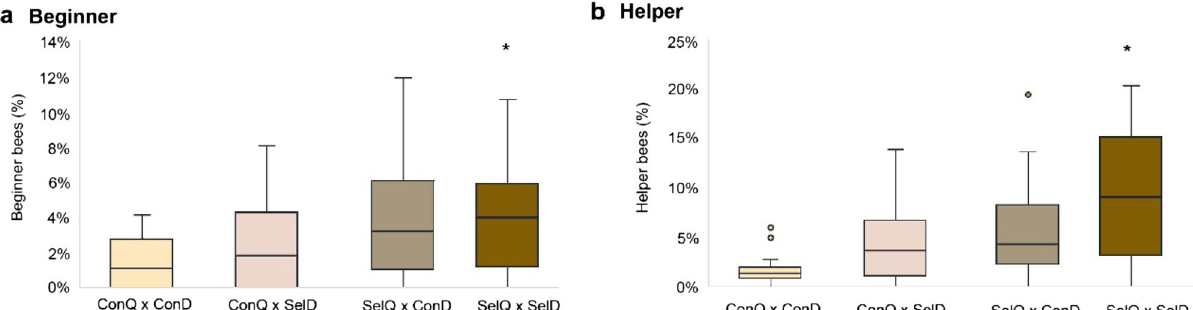
Figure 4. Boxplot of beginner and helper bees in groups based on the genetic origin of the queens and drones. Displayed are median, standard deviation and outliers for the beginner ( a ) and helper ( b ) categories for each group. The proportion of beginner ( a ) and helper ( b ) bees during the three courses of the video observation experiment are displayed for each group. One colony exhibited 19.4% helper bees (outlier—group SelQ × ConD ). The number of colonies tested per group was as follows: 9 ( ConQ × ConD), 9 ( ConQ × SelD ), 10 ( SelQ × ConD ) and 11 ( SelQ × SelD ). *Proportion of beginner and helper bees at the level of 0.001 significantly higher than reference group ConQ × ConD (beige